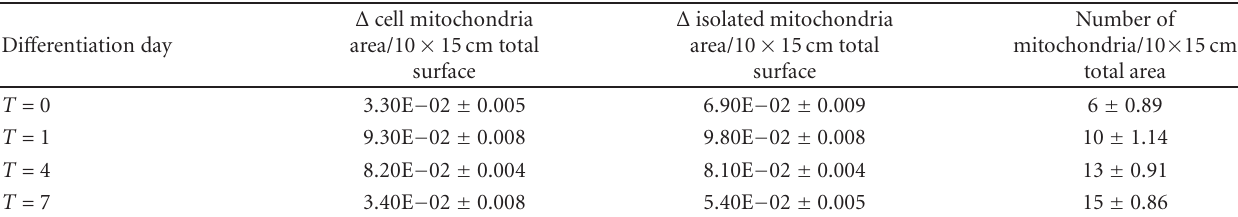
Table 2: Mitochondrial area and number variability during di ff erentiation by means of ultrastructural observations of resin-embedded